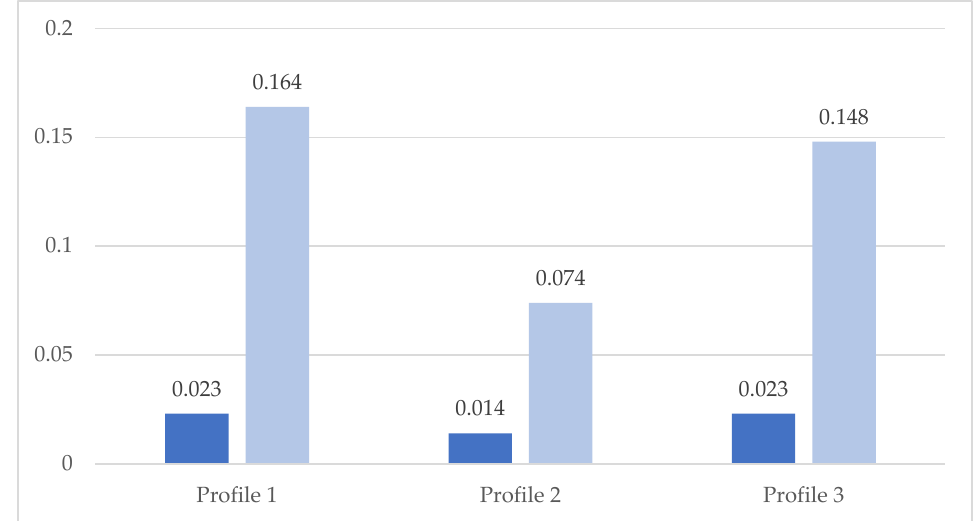
26 Figure 35. C2C analysis. Zenmuse P1 and L1 compared with SX10 data: standard deviation (m) in light orange; mean distance (m) in orange. The ICP alignment of the tower resulted in an interesting analysis. Regarding the L1 data, they were aligned with the TLS clouds. The CloudCompare software calculated a final RMSe of 0.199 m and the following translations: x −0.101; y 0.036; and z −0.199. The P1 data alignment generated an RMSe of 0.052 m; the translation adjustments on x, y, and z are −0.057, 0.018, and 0.006, respectively. By analysing these results, photogrammet ric data were revealed to be extremely accurate and reliable compared with terrestrial acqui- sitions: in fact, centimetric shifts were calculated among two different outputs, as were millimetric movements on the z axis. ICP registration and alignment continued with the custom profile analyses. The